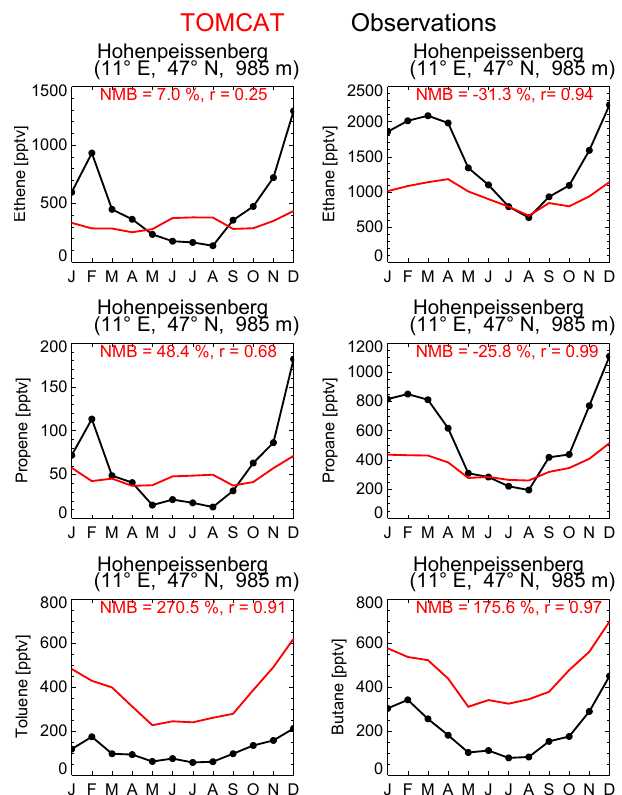
Figure 11. Monthly mean 2008 observed and simulated VOCs (pptv) at the European high-altitude observatory, Hohenpeis- senberg. Pearson correlation ( r ) and normalised mean bias (NMB) between the observed and simulated monthly mean data are printed on each